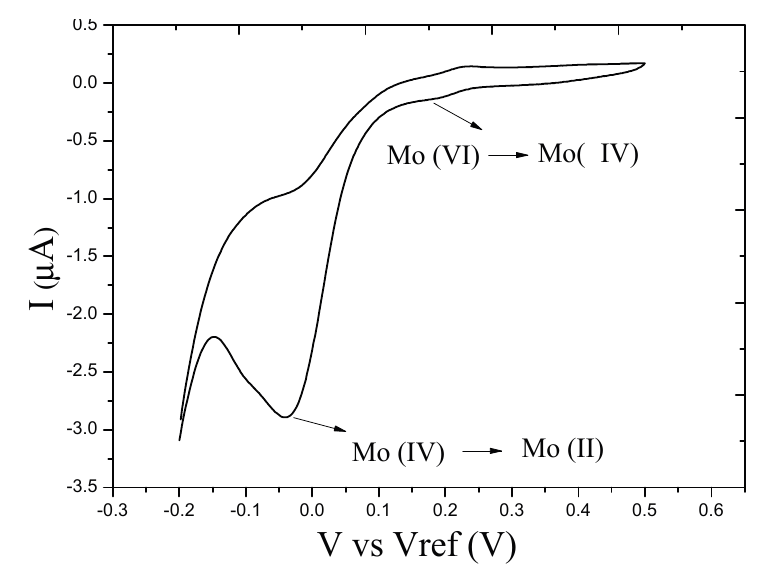
Figure 2. Cyclic voltammetric responses of molybdophosphate complex with an unmodified